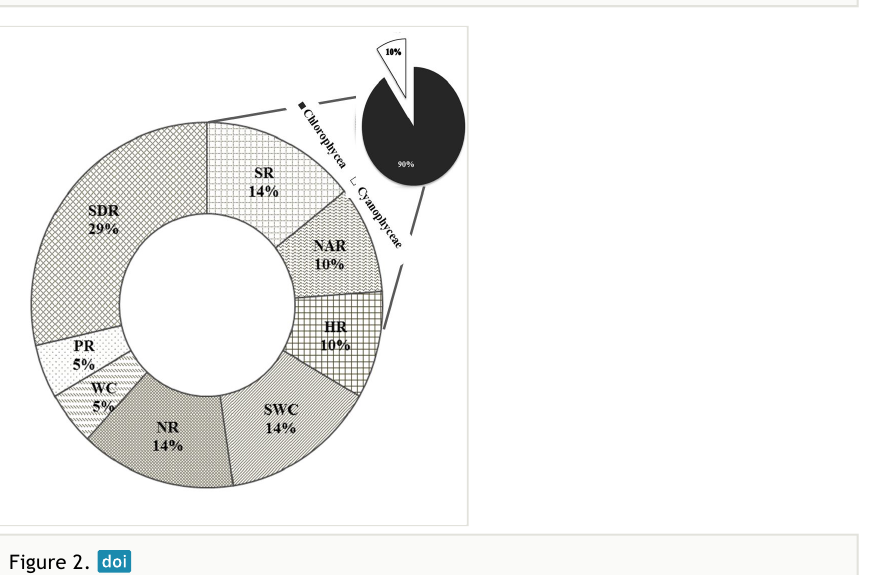
Figure 2. Relative abundance of the morphotypes and classes of microalgae identi fi ed in the di ff erent hydrographic zones evaluated in the state of Chiapas. SR: Suchiate river; NAR: Nandayapa river; HR: Huixtla river; SWC: Spring water Cahuaré; NR: Novillero river; WC: Wastewaters "La chacona"; PR: Pijijiapan river; SDR: Santo Domingo